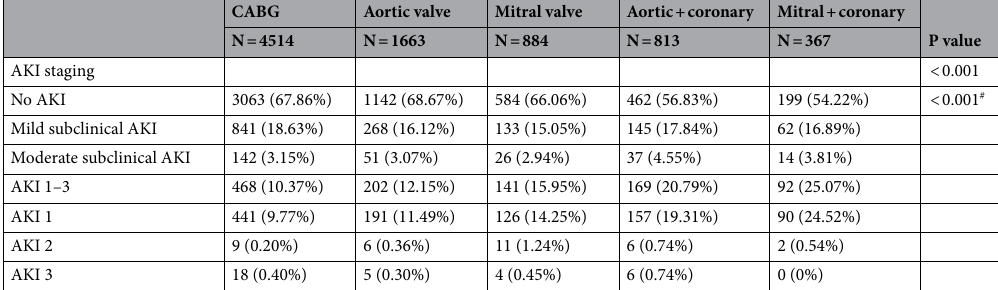
Table 1. Descriptives table per operation type. All values presented as mean (95% CI), and categorical variable with the percentage in parentheses. BMI body mass index, eCCR estimated creatinine clearance, CPB cardio-